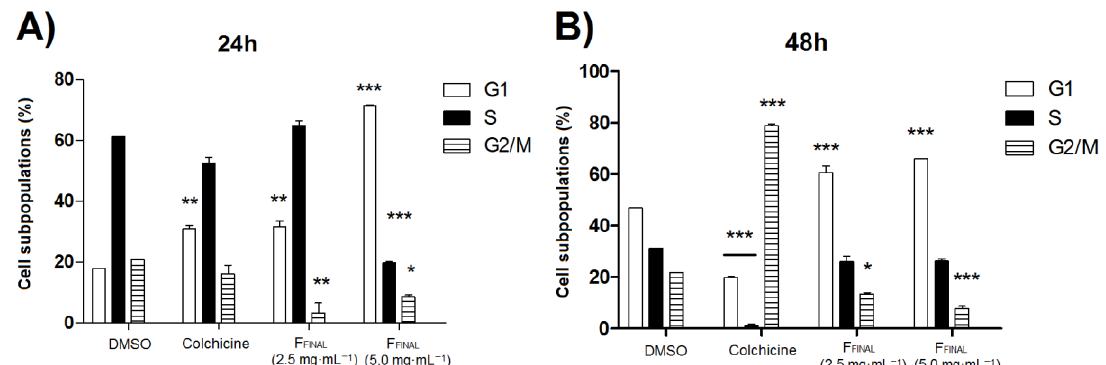
Figure 4. Cell population, expressed in percentage for each phase of cell cycle G1, S and G2, after ( A ) 24 h-treatment and ( B ) 48 h-treatment with vehicle, colchicine (0.25 μg ·mL − 1 ) or FFINAL fraction (2.5 and 5.0 μg ·mL − 1 ). Data are derived from an experiment performed; standard deviations are indicated by error bars. Results expressed as mean ± standard deviation. Statistical analysis by One-way ANOVA followed by Tukey ’ s Test * p < 0.05, ** p < 0.01 and *** p < 0.001 (ANOVA). * Statistical difference compared to cells control.